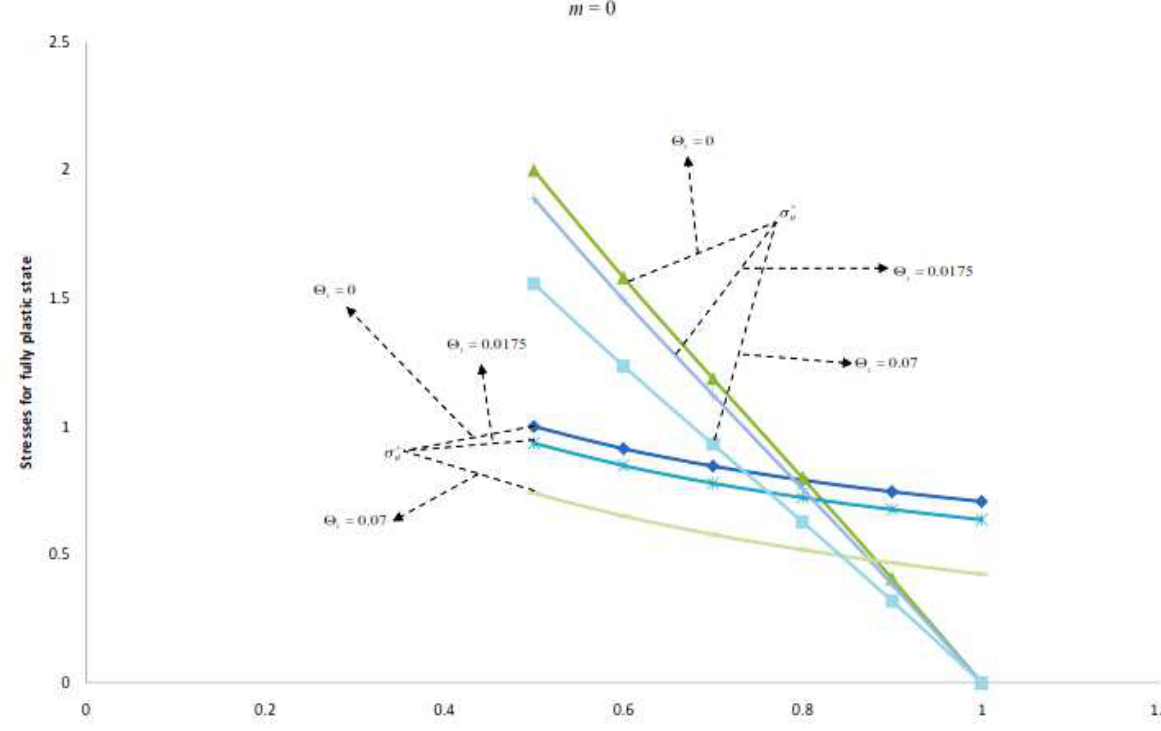
with respect to radii ratio